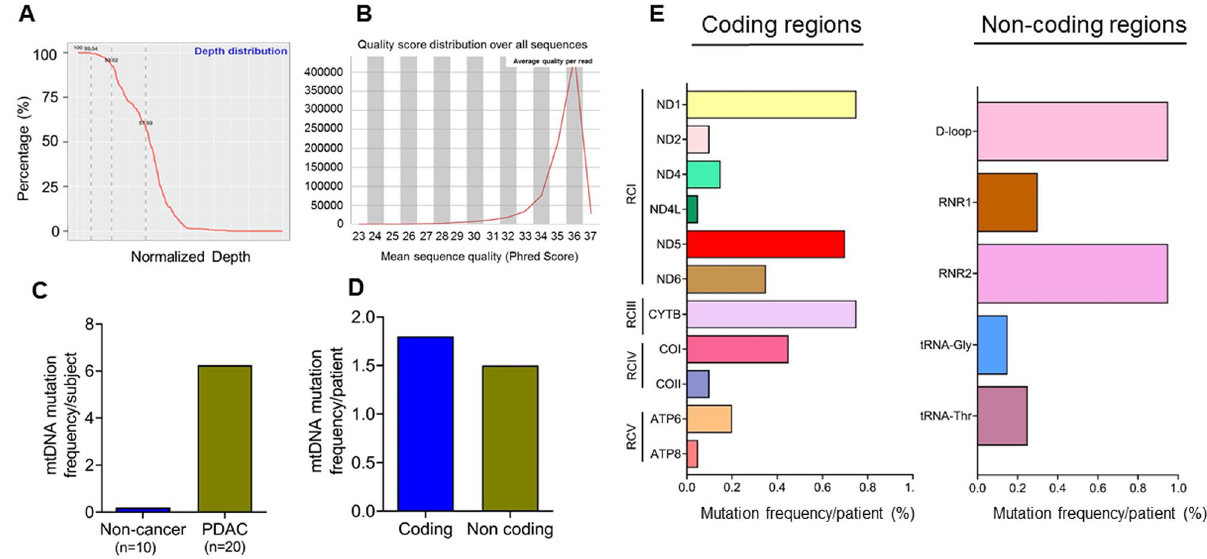
Figure 3. Mutation analysis of mitochondrial DNA. ( A ) Depth of mtDNA sequencing (coverage) and ( B ). quality analysis (Phred score) as assessed before variant calling. ( C ) Mutation frequency of mtDNA in EV from PDAC and non-cancer subjects. ( D ) Total mutation frequency of mtDNA in coding and non-coding regions of the mtDNA in PDAC subjects. ( E ) Regionwise distribution of mutation frequency of mtDNA in in PDAC subjects RC: Respiratory complex. ND : NADH Dehydrogenase; CYTB : Cytochrome B; CO: Cytochrome C Oxidase; ATP6 ; ATP Synthase Membrane Subunit 6; ATP8 : ATP Synthase Membrane Subunit 8. RNR1 : RNA, ribosomal 1, RNR2 : RNA, ribosomal 2.